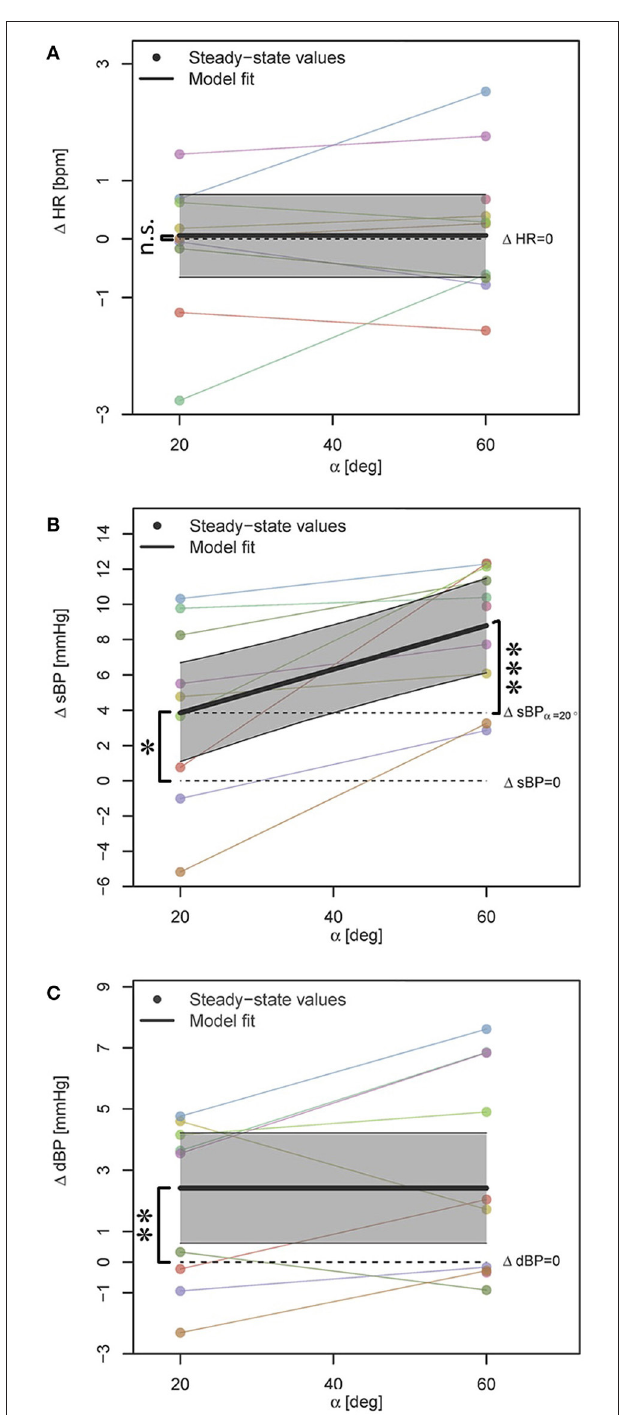
FIGURE 3 | Statistical models for 1 HR, 1 sBP, and 1 dBP responses to PE (A–C) when the effect is decoupled from the head-up tilting effect. Data points correspond to the average steady-state response to 24 and 48 steps per min on 2 days. In case of availability of only single case measurement, data point without averaging is shown. The steady-state values for each subject are color-coded and connected with a line. The highlighted areas show 95% CI. The signs *, **, and *** mark significant findings with p ≤ 0.05, 0.01, and 0.001, respectively. n . s . marks non-significant